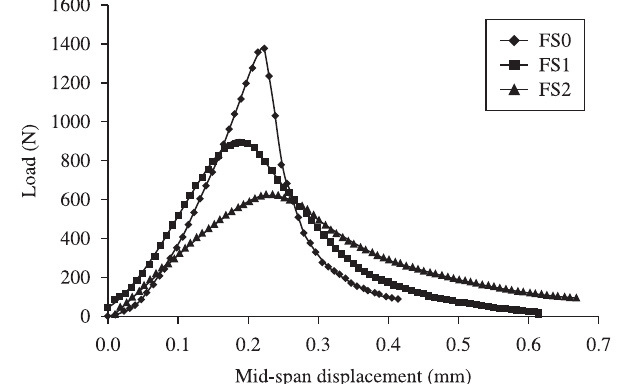
Figure 3. Load vs. Mid-span Displacement of fresh sand textile reinforced polymer mortar.